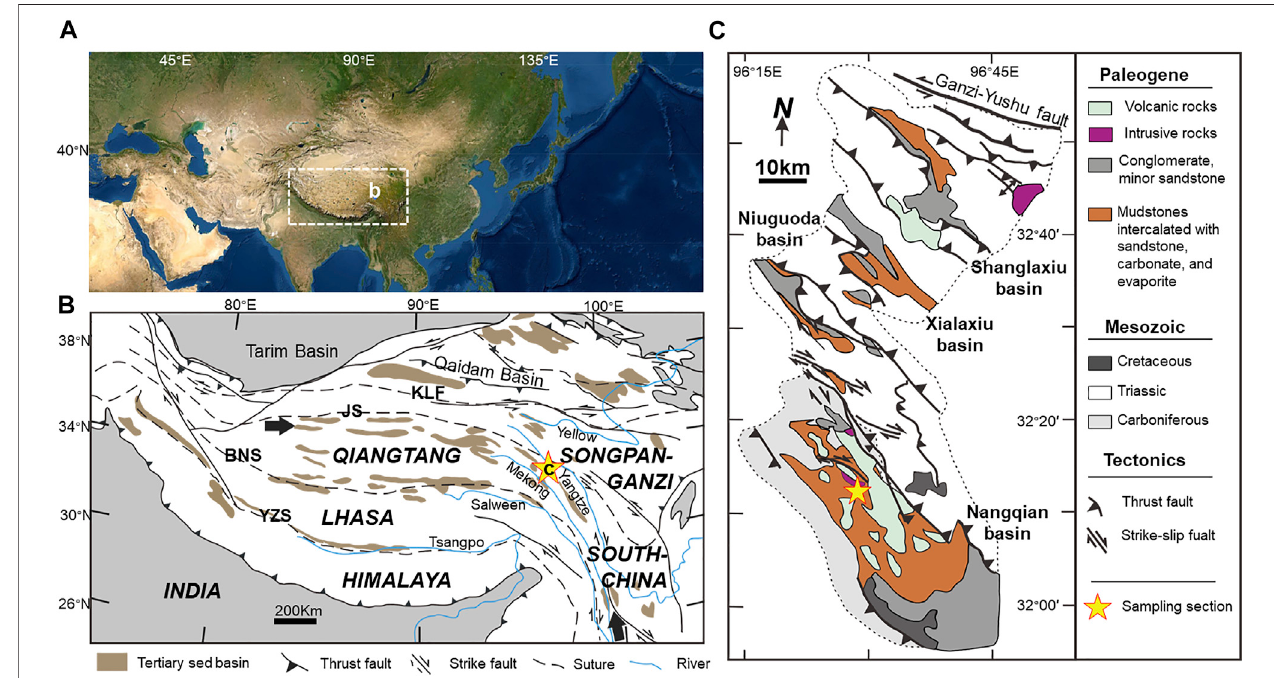
FIGURE1|(A) Locationand (C) geologicalmapoftheNangqianBasinand (B) neighboringbasinsintheeasternTibetanPlateau.Both (B,C) aremodi fi edfromthe work of Horton et al. (2002).